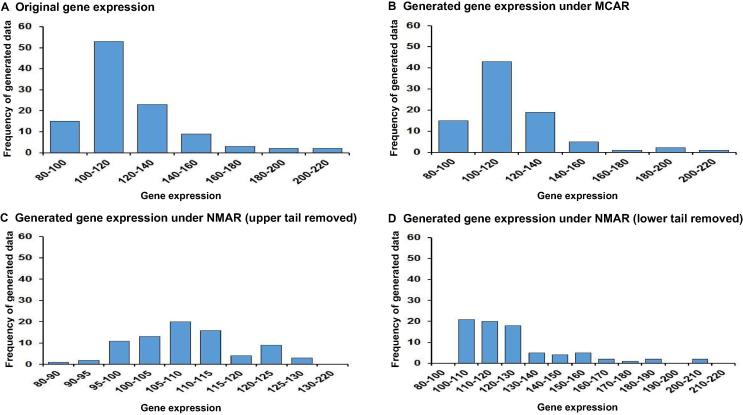
Generating missing values in lung cancer dataset as exemplified for RFC2 geneA. The histogram of the gene expression for RFC2 gene in the original lung cancer dataset. B. The histogram of the gene expression for RFC2 gene in the generated lung cancer dataset after removing values under MCAR. Histograms of the values of gene expression after removing the upper and lower tails under NMAR, respectively, are shown in panels C and D, respectively. RFC2, replication factor C subunit 2; MCAR, missing completely at random; NMAR, not missing at random.